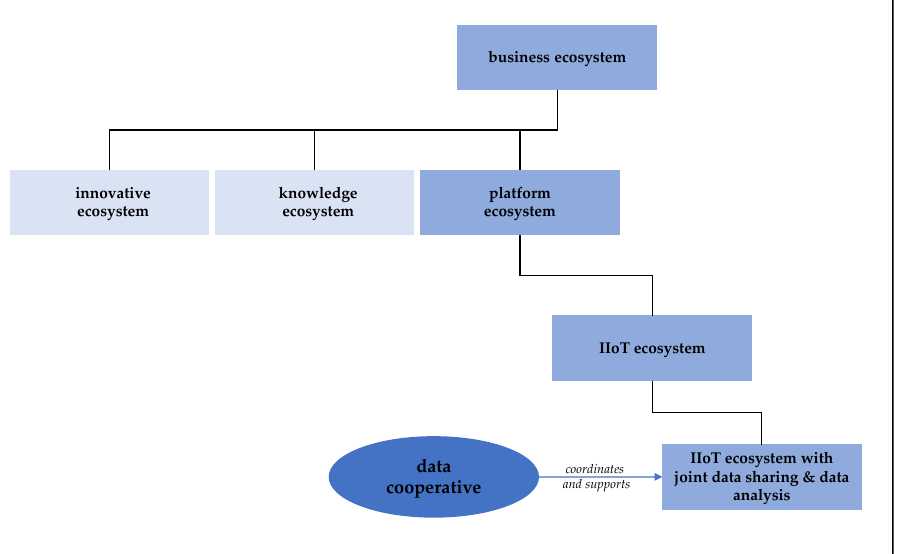
Figure 3. Business ecosystems typology, based on [5,49].